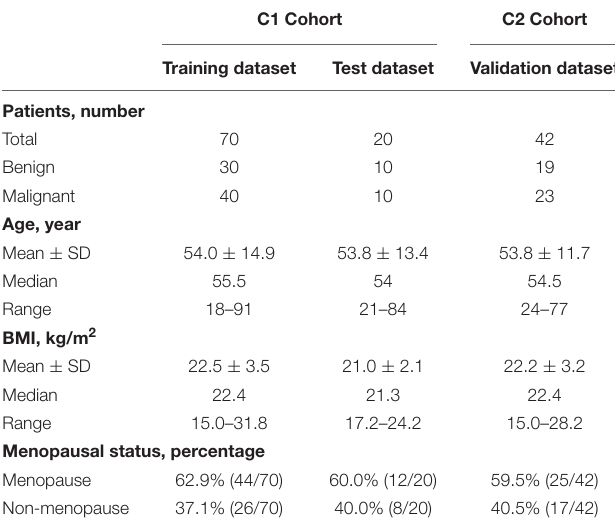
TABLE 1 | Clinical information of patients in this study.